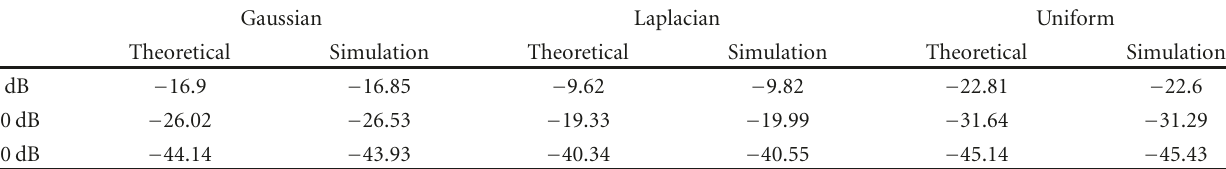
Table 1: Theoretical and simulation EMSE for p = 4, α = 0 . 2.